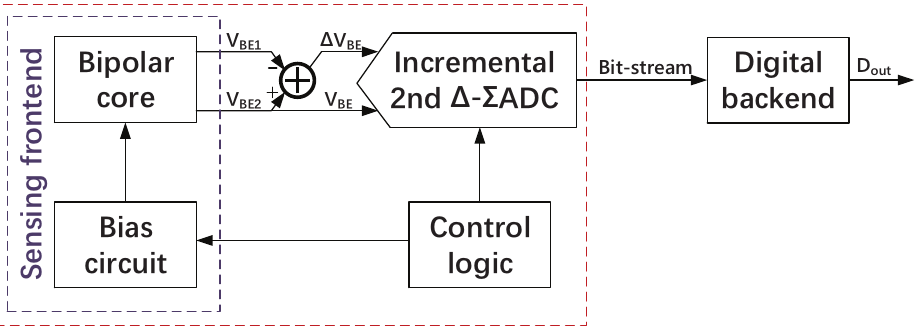
Figure 2. Block diagram of the proposed temperature